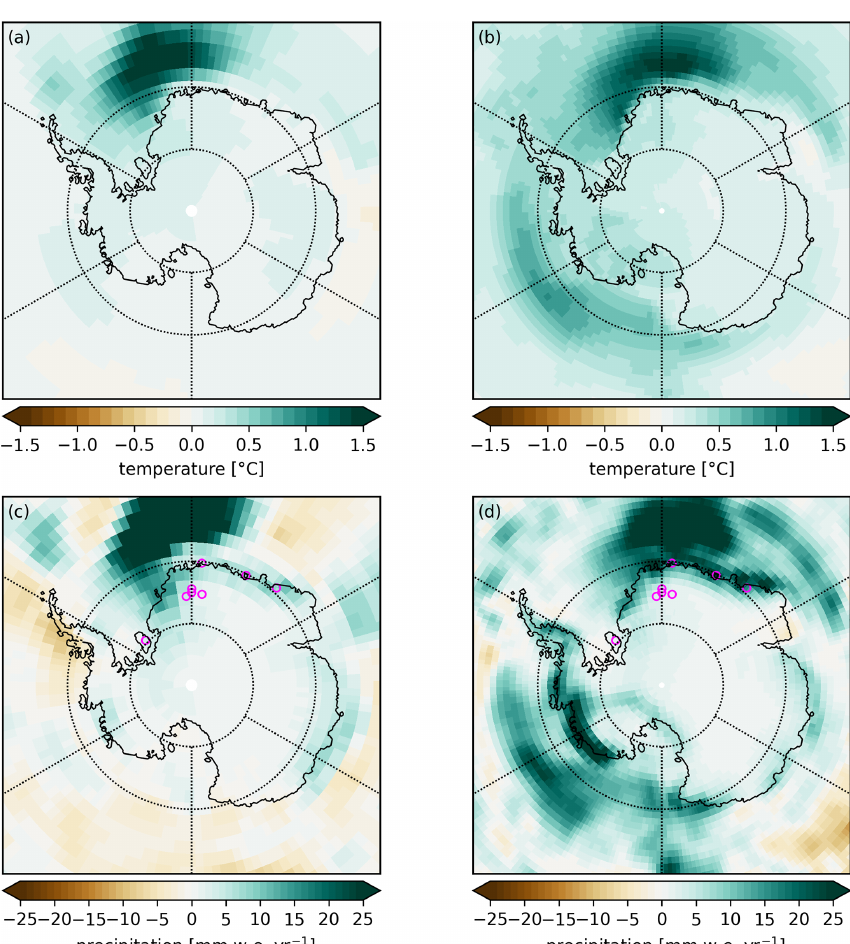
Figure 5. Regression of (a) annual mean temperature ( ◦ C) and (c) precipitation (mm w.e.yr − 1 ) scaled to correspond to 1 standard deviation change in the annual mean ocean mixed layer depth in the eastern Weddell Sea between 50 ◦ W and 50 ◦ E, south of 60 ◦ S over the years from 2000 to 3000 of the SPEAR_AM2 simulation. (b, d) Same as panels (a) and (c) but for the years from 3000 to 4000 of the SPEAR_LO simulation. The circles in panels (c) and (d) correspond to the location of the ice cores in Table 1 with the B40 core shifted northward by 0.6 ◦ in order to avoid an overly large overlap with nearby